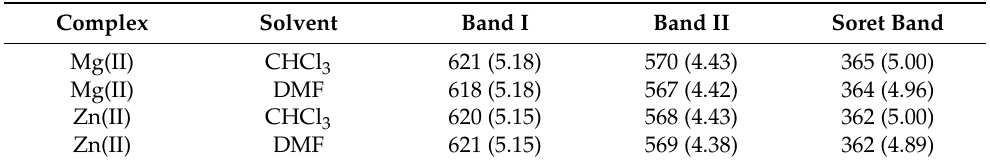
Table 1. UV–Vis spectra of Mg(II) and Zn(II) complexes with octa-(2,6-difluorophenyl)tetraazaporphyrin λ , nm, lg( ε